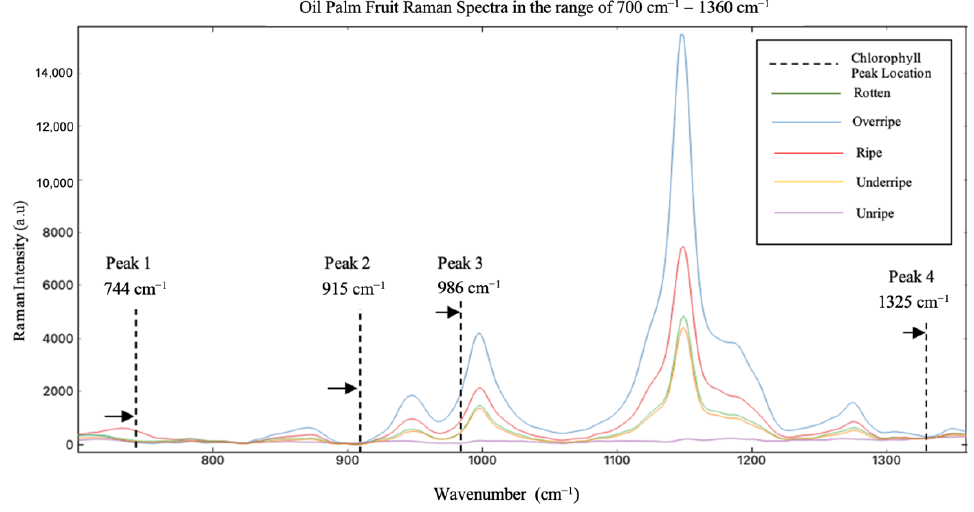
Figure 4. Raman spectra of oil palm fruit in the range from 700 to 1360 cm -1 . Table 1. Summary of Raman bands and their molecular assignments and vibrational modes from this study and previous works.